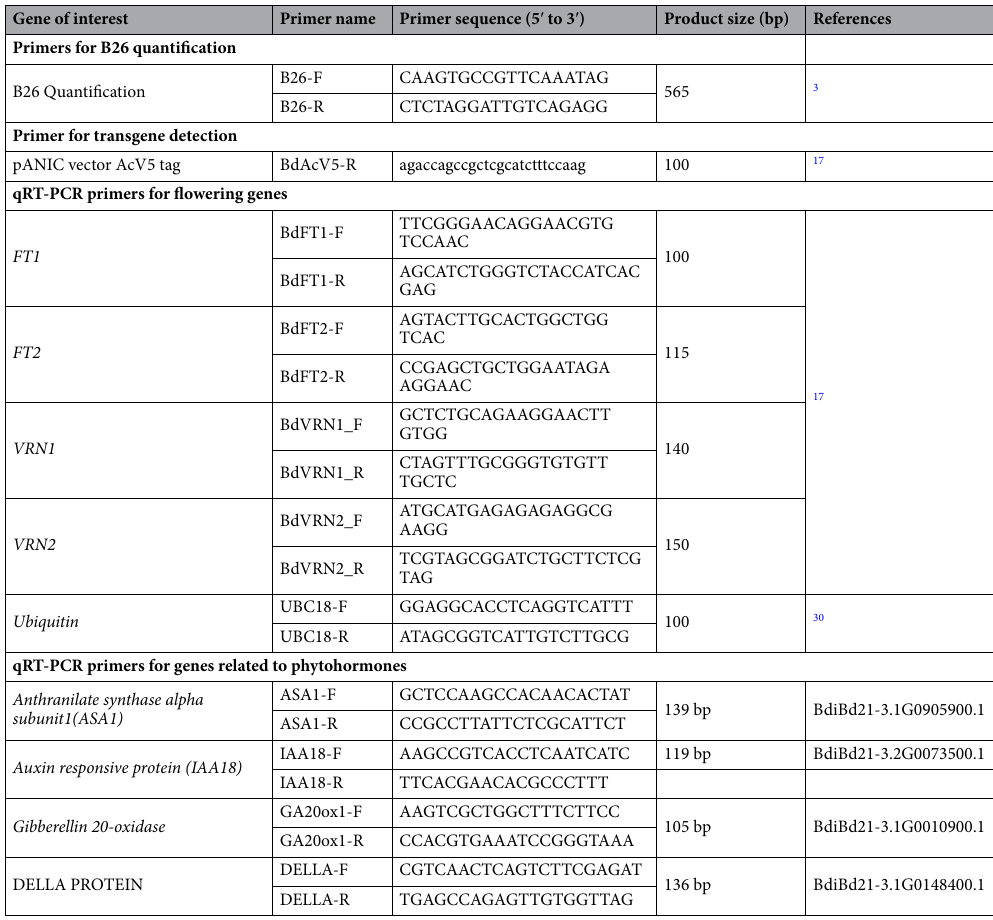
Table 3. List of primers used in this